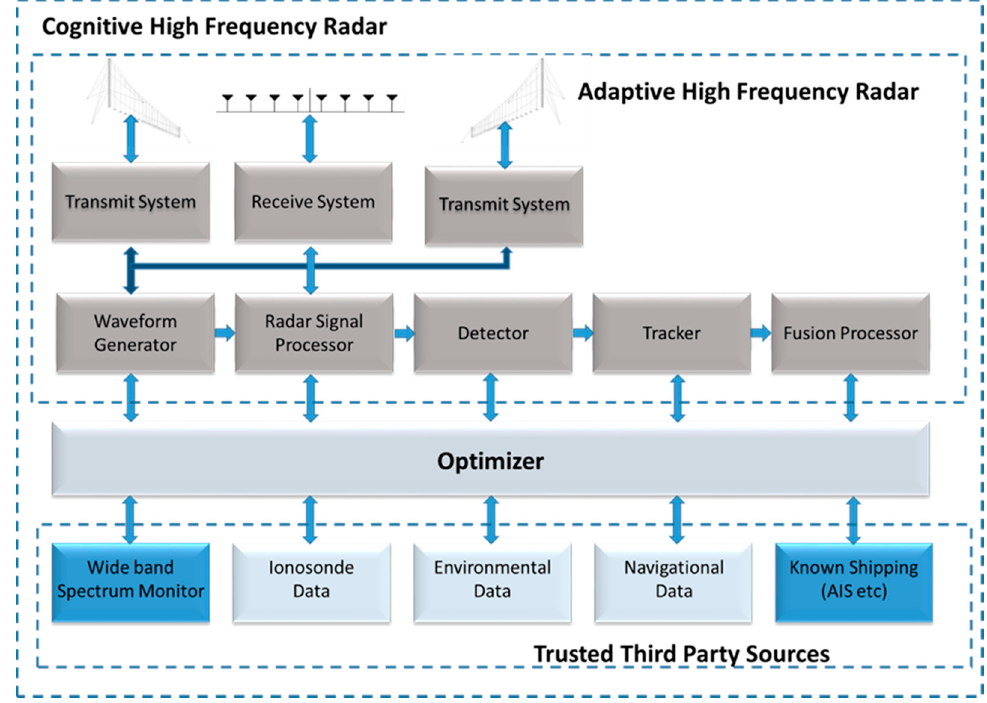
Figure 4. Canada’s third-generation cognitive HFSWR system consisting of an adaptive HFSWR (Act), the ingestion and processing of data into the optimizer (Sense), the determination of the optimum radar processing for the mission (Learn) and the application of optimized processing parameters (Decide).